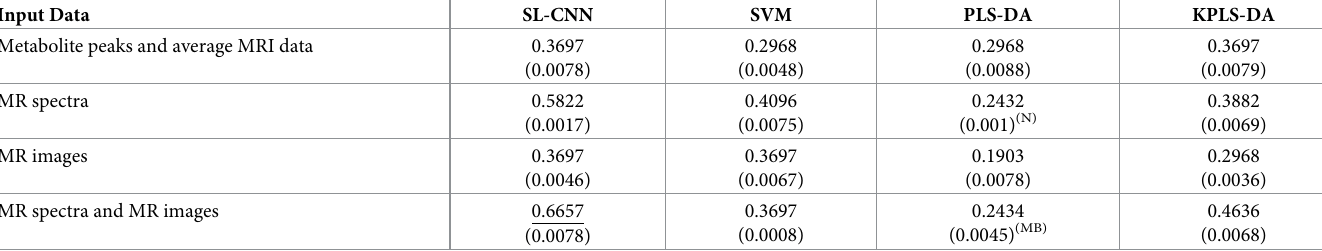
Table 2. Average classification MCC score assessed by LOPO-CV to separate voxels with grade II versus grade III tissue in the brain tumor dataset. MBPLS-DA is used instead of PLS-DA for the last line given the multiple types (i.e. MR spectra and MR images). Average MRI data are obtained from MR images by averaging pixels intensities for all voxels. Metabolites peaks, corresponding to brain metabolites, are quantified from MR spectra. Full MR spectra means that complete spectra are used as input data. Standard deviation is reported below each score between brackets. The best results are underlined.